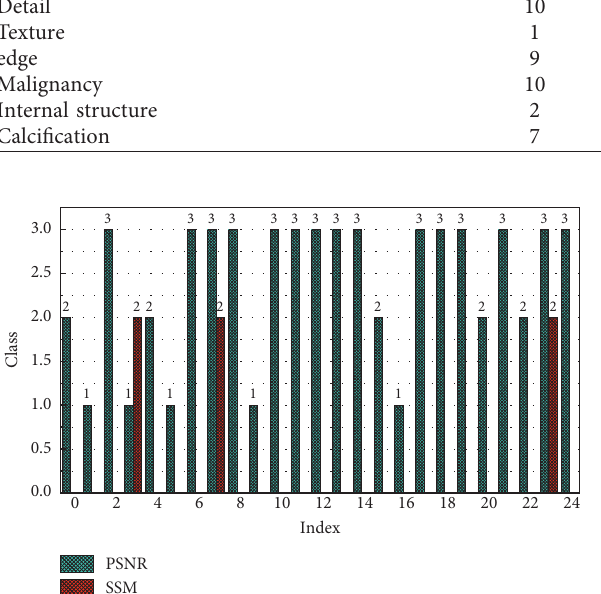
Figure 2: Graph of parameter versus average